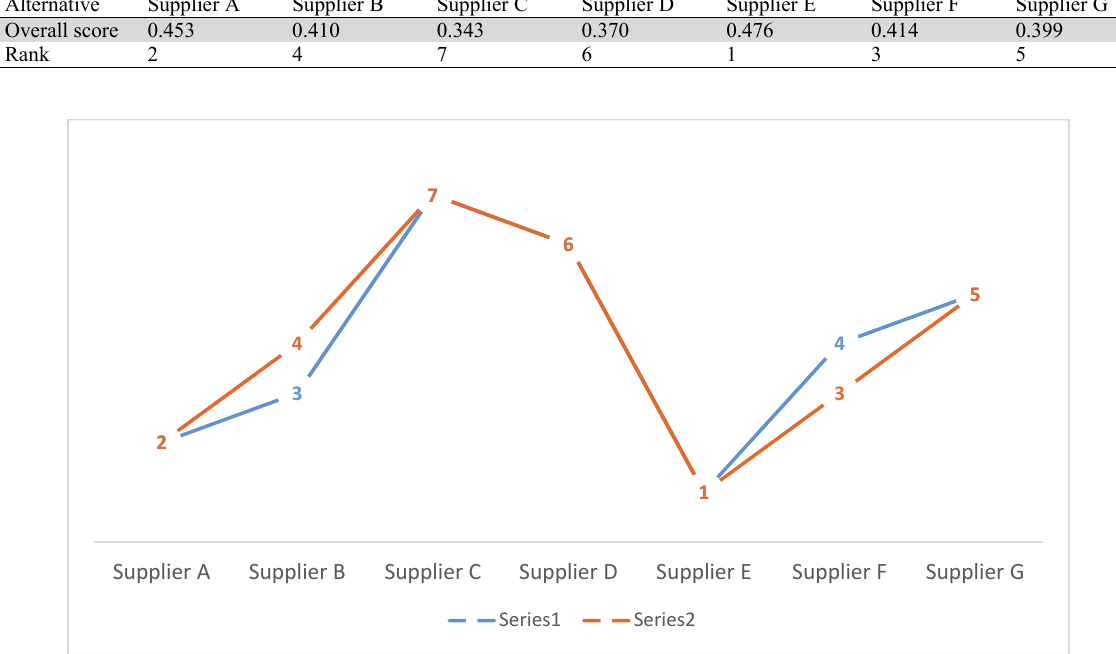
Fig. 4. The rankings of the alternatives in the nominal and the uncertain problem of part 2